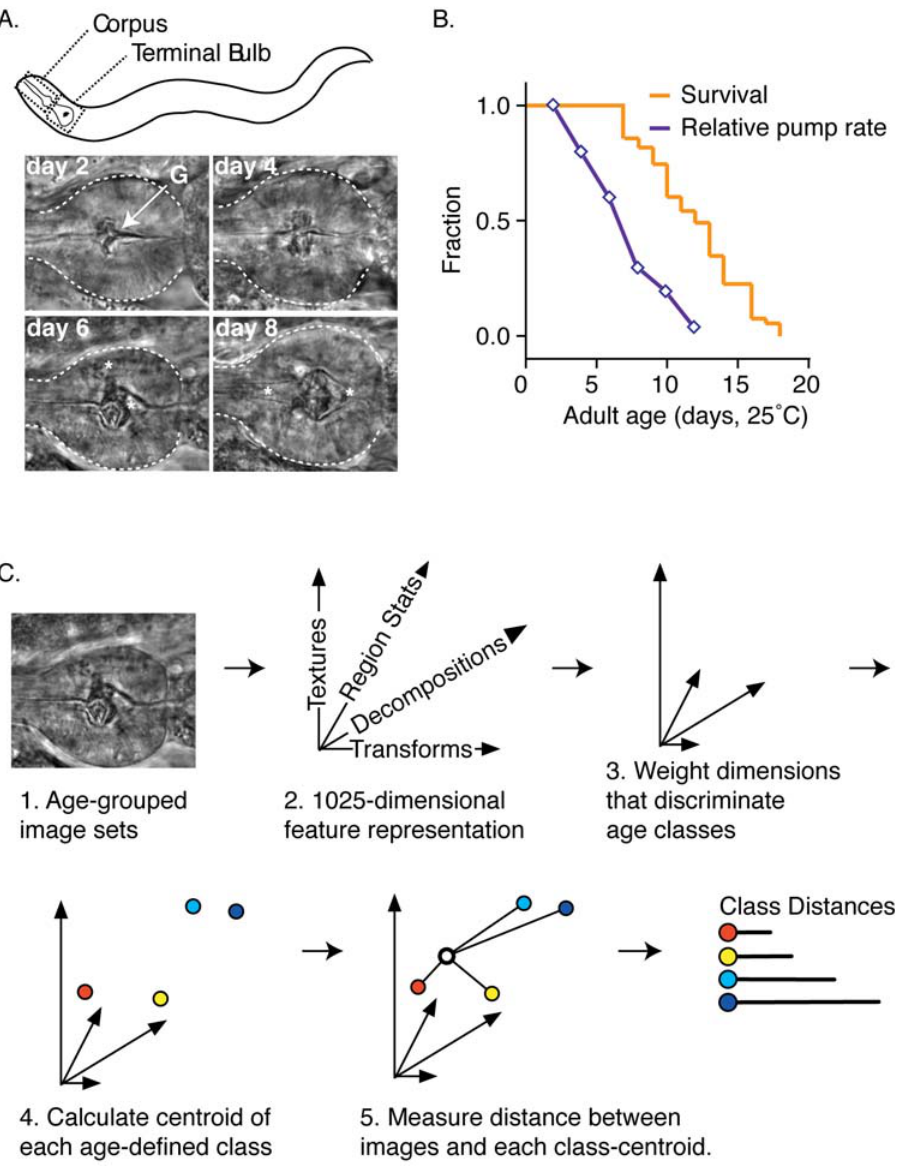
Figure 1. Overview of whole-image analysis. (A) Anatomical description of the C. elegans pharynx during adulthood. Cartoon illustrates the pharynx’s relative position in the head, and representative images of the terminal bulb from four different ages are shown. Bacteria are ingested through the stoma, or mouth, and concentrated in the corpus region. Concentrated bacteria are passed to the terminal bulb (outlined with a dashed line for clarity) for mechanical disruption in the grinder (G) before transfer to the intestine. Structural aging is evident in the terminal bulb between adult days 2–8 as deterioration of the striated muscle fibers and disorganization in the grinder. (B) Declines in survival and pump rate occur during normal aging in C. elegans . Shown are representative curves for adult survival and pump rate (relative to day 2) in a population of fem-1(hc17) animals at 25 u C. (C) General outline for the procedures used in pattern analysis of pharynx images (see text). 85 training images were used for each age group. The resulting class distances form the basis for similarity measurements and age-score predictions.